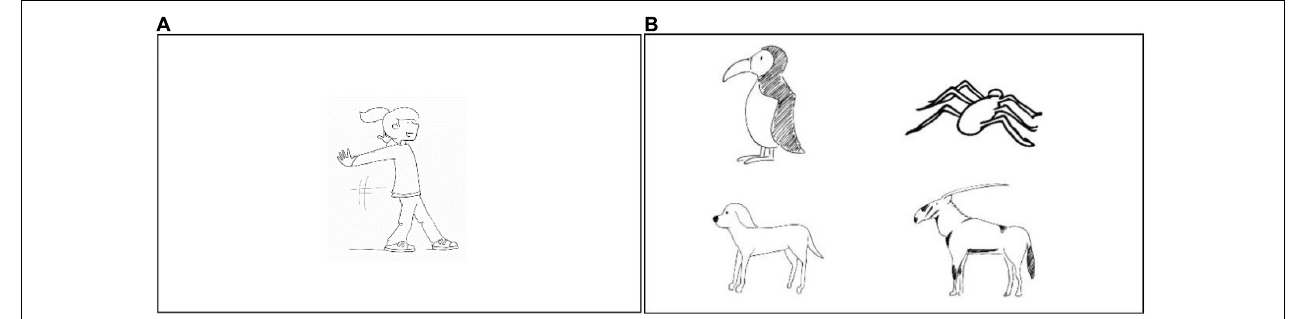
FIGURE 5 | Monitor screen during (A) the production task and (B) the reception task. In the example for (A) , the girl is performing the action “to slide.” In the example for (B) , at the bottom right, the referent for the target word “beisa” is displayed. A distractor object that looks similar to the target referent is presented to the left of the “beisa”. In the first row on the left, another target word, “auk,” is presented as a distractor. Next to the “auk,” a random referent is shown as an additional distractor (Copyright © 2013 Joy Katzmarzik leap4joy graphics; reprinted with permission).